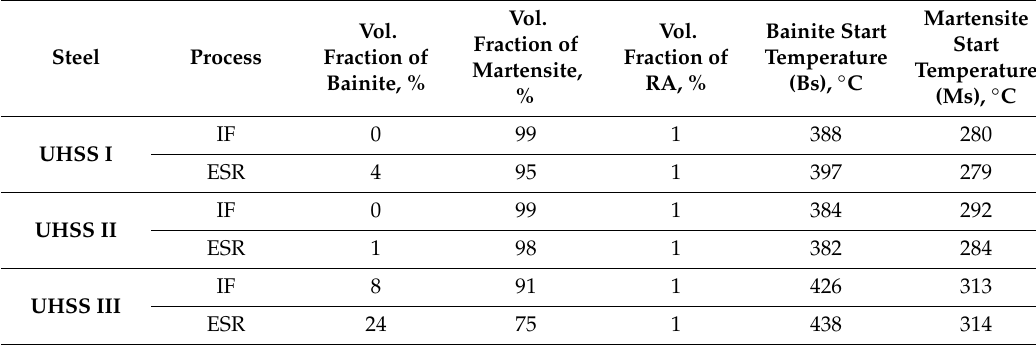
Table 3. Results from simulations of the CCT behavior of the composition of UHSS I, II and III without and with ESR using JMatPro software